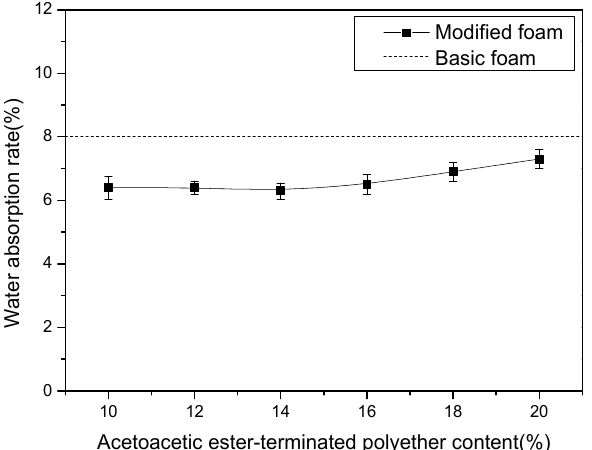
Figure 10. The effect of the acetoacetic ester-terminated polyether with different contents on the water absorption rate of the foam.